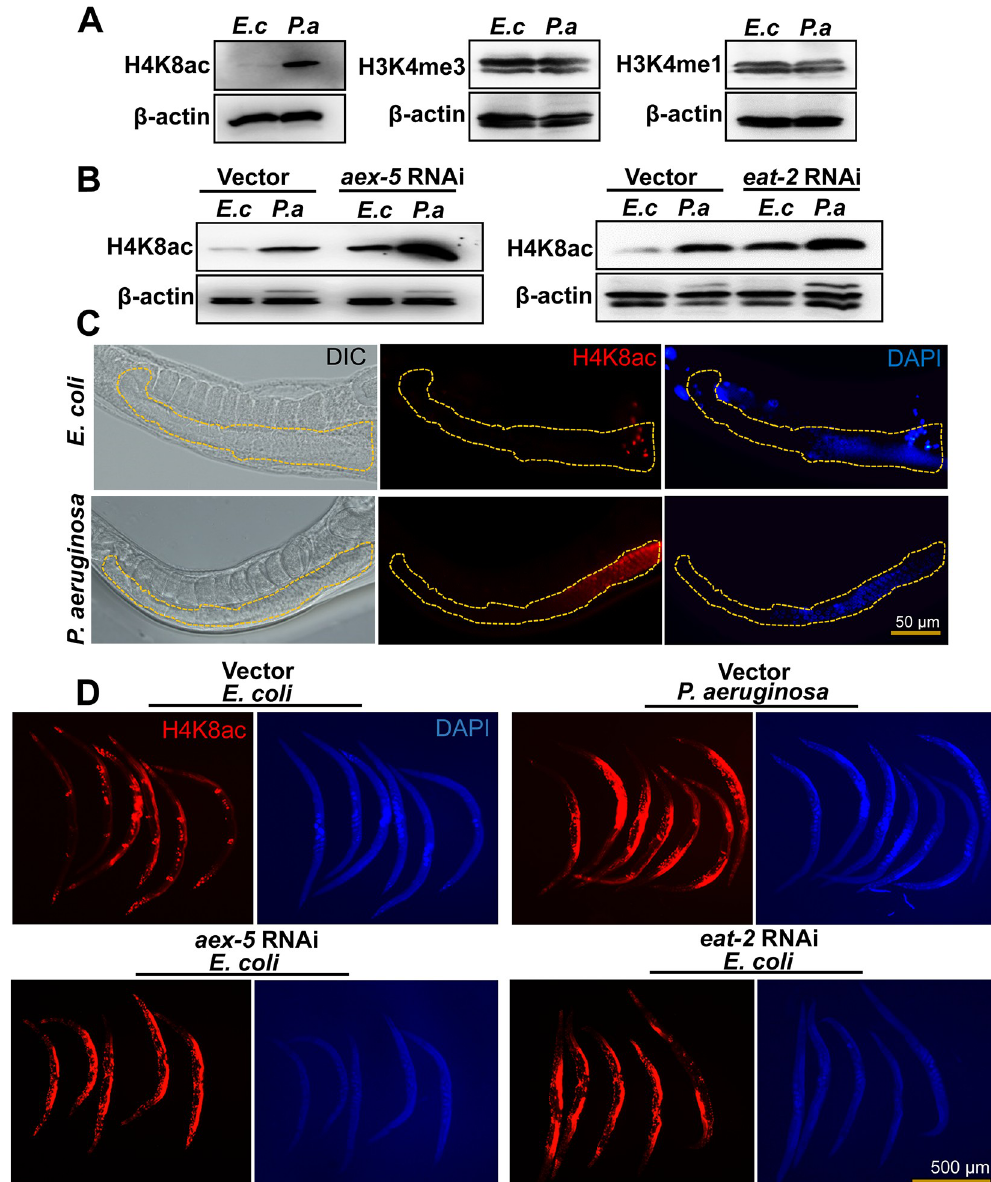
Fig 1. P . aeruginosa infection and intestinal distension induce H4K8ac in the germline. (A) Western blots of extracts from fer-1(b232) animals exposed to E . coli ( E . c ) or P . aeruginosa ( P . a ) for 24 hours at 25˚C ( n � 1,000; representative of 3 independent experiments). (B) Western blots on extracts from fer-1(b232) animals exposed to E . coli ( E . c ) or P . aeruginosa ( P . a ) following aex-5 and eat-2 RNAi for 24 hours at 25˚C ( n � 1,000; representative of 3 independent experiments). The fer-1(b232) animals were maintained at 15˚C. To induce sterility, L1-stage animals were transferred to 25˚C and allowed to develop. L4-stage animals were then transferred to RNAi plates and allowed to grow for 24 hours at 25˚C. “n” represents the number of animals for each experiment (A, B). (C) Representative microscopic images of portions of C . elegans germline depicting differences in H4K8ac patterns. Yellow-dotted lines were used to outline the germline. (D) Whole-mount immunofluorescence profile of wild-type animals stained with anti-H4K8ac antibody, post exposure to E . coli ( E . c ) or P . aeruginosa ( P . a ) following aex-5 and eat-2 RNAi for 24 hours at 25˚C. See S1 Raw Images for uncropped immunoblot images. H4K8ac, histone H4 Lys8 acetylation; RNAi, RNA interference.